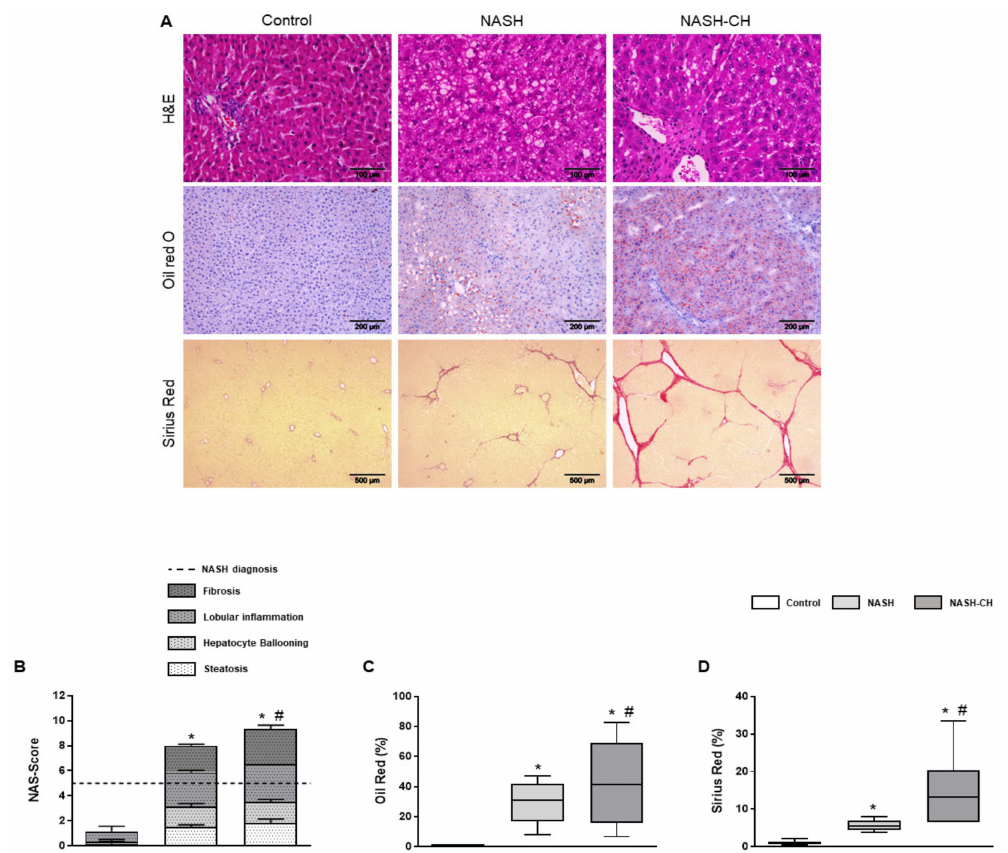
Figure 2. Liver histology of control and NASH rats. ( A ) Histopathological images from control, NASH, and NASH-CH livers. Hematoxylin and eosin (H&E) staining (top row; scale bar = 100 µ m), oil red O staining (second row; scale bar = 200 µ m) and Sirius red staining (bottom row; scale bar = 500 µ m). ( B ) NAS-Score quantification. ( C ) Oil red O quantification. ( D ) Sirius red quantification. Results represent mean ± SEM, * p < 0.05 vs. control group, # p < 0.05 vs. NASH group ( n = 6 rats per